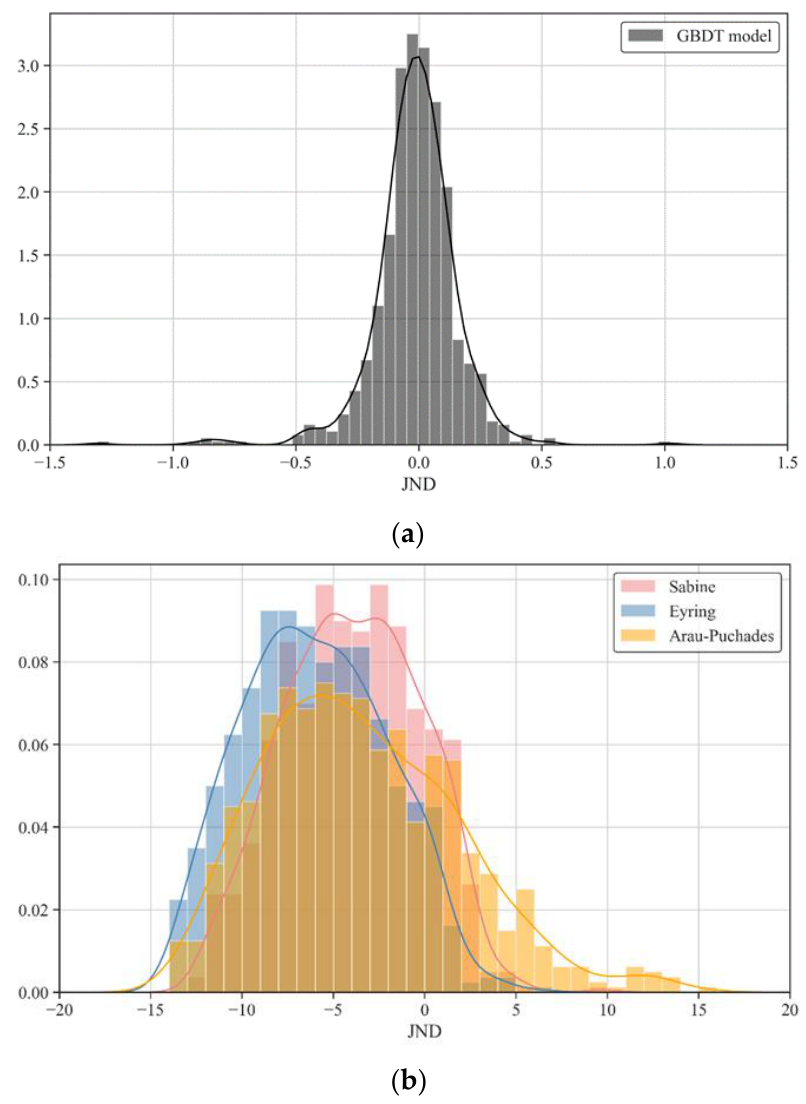
Figure 22. JND distribution histogram of reverberation time: ( a ) GBDT model; ( b ) Traditional estimation formulas.